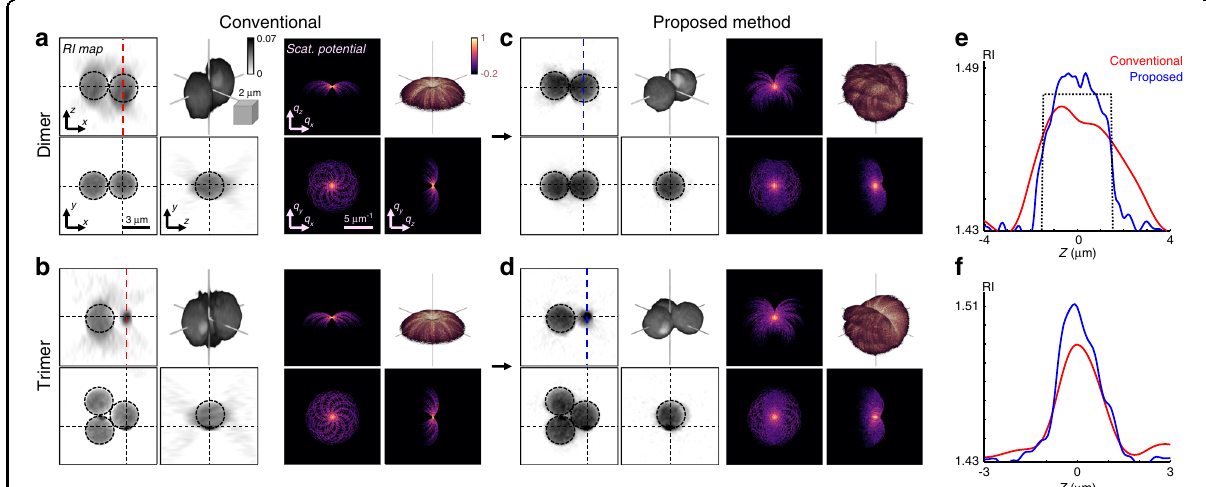
Fig. 3 3D RI reconstruction of PMA multimers. a, b RI tomograms and the corresponding scattering potential spectra of a PMA ( a ) dimer and ( b ) trimer using the conventional ODT. c , d Corresponding results of the PMA ( c ) dimer and ( d ) trimer using our proposed method. (Dashed lines, 2D slice regions; inset, 3D-rendered images). e , f Line plots along the coloured dashed lines for ( e ) the dimer and ( f ) trimer (dashed circles, guiding lines for ideal 3 μ m diameter spheres with RI of